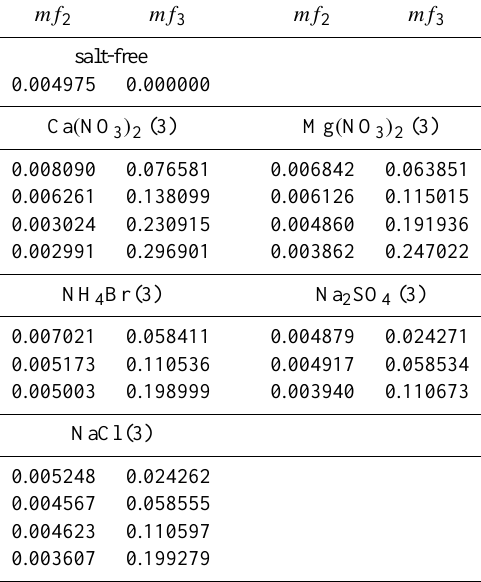
Table A14. Measured solubility limits of 2,4- dihydroxybenzaldehyde in different ternary solutions of water (1)+2,4-dihydroxybenzaldehyde (2)+salt (3) at T = 298 . 15K. Aqueous solution compositions are given in mass fractions ( mf j